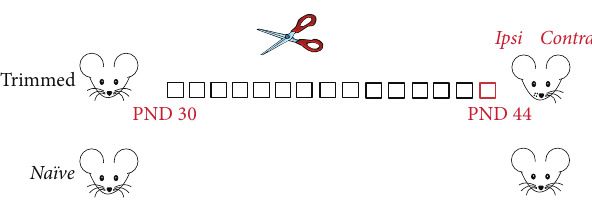
Figure 1: Whisker trimming procedure. Cartoon depicting the whisker trimming protocol. Wild type and mCREB mice underwent 14 days of unilateral whisker deprivation starting at 30 days of age or left undisturbed in their home cage ( Na¨ıve ). PND: postnatal day. At the end of trimming period, brains were separated and the two hemispheres were identified as ipsilateral ( Ipsi ) or contralateral ( Contra ) to trimmed mystacial